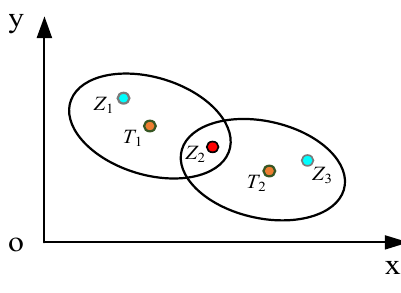
Figure 3. Data-association